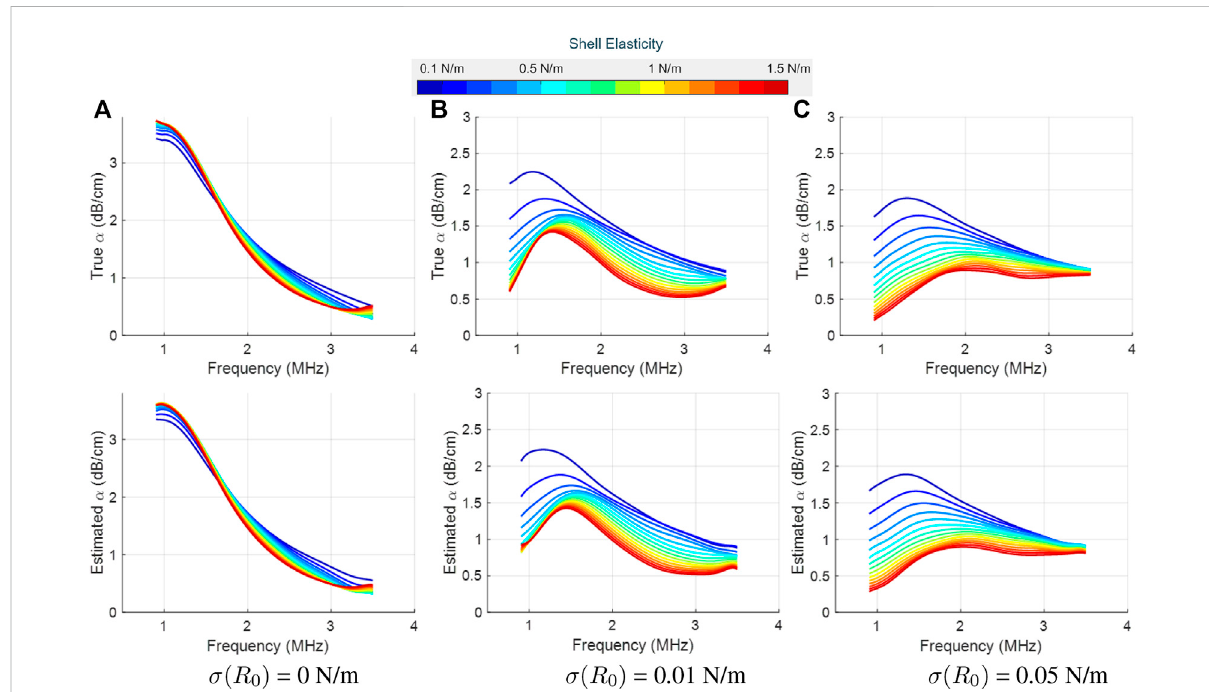
FIGURE 4 True (top row) and LLS estimated (bottom row) attenuation spectra for SonoVue with κ s = 5 × 10 − 9 kg/s at an acoustic pressure of 10 kPa, as a function of the shell elasticity (values shown in the colorbar). Column-wise, the plots are for three different initial surface tension values: (A) σ ( R 0 )